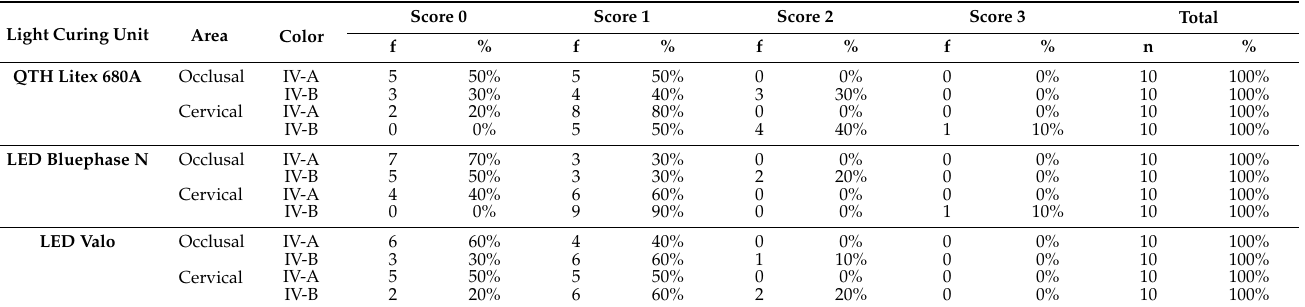
Table 2. Occlusal and cervical microleakage of dental restorations with Tetric N-Ceram resin compos- ite according to light-curing